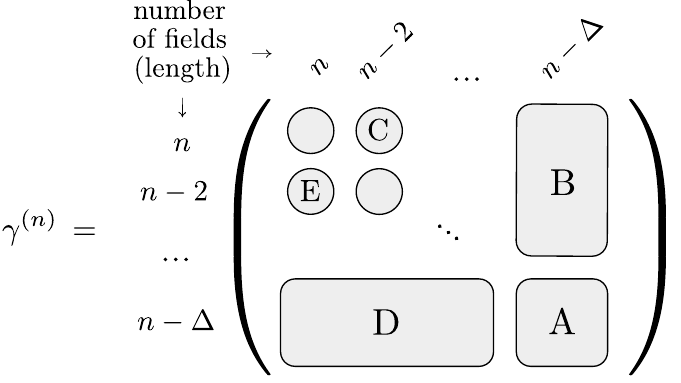
Figure 3 . Schematic representation of the structure in the anomalous dimension matrix of the complex scalar at mass dimension n in a natural basis. A: sub-matrices on the diagonal encode intra-length mixing. They depend only on the conformal primary part of operators and become symmetric at one-loop for orthonormal operators. B: Sub-matrices on the upper triangle encode inter-length mixing of a smaller operator into a larger operator — generally non-zero in a basis of primaries. C: Entry corresponding to the mixing of O ( n ) into O ( n ) — one-loop zero only if O ( n ) n n - 2 n - 2 is conformal primary. D: Sub-matrices on the lower triangle encode inter-length mixing of a larger operator into a smaller operator — zeros up to L = ∆ , explained by [28]. E: Entry corresponding to the mixing of O ( n ) into O ( n ) , three-loop zero for any O ( n ) . This result is stronger than the minimal n n - 2 n - 2 non-renormalization result predicted by